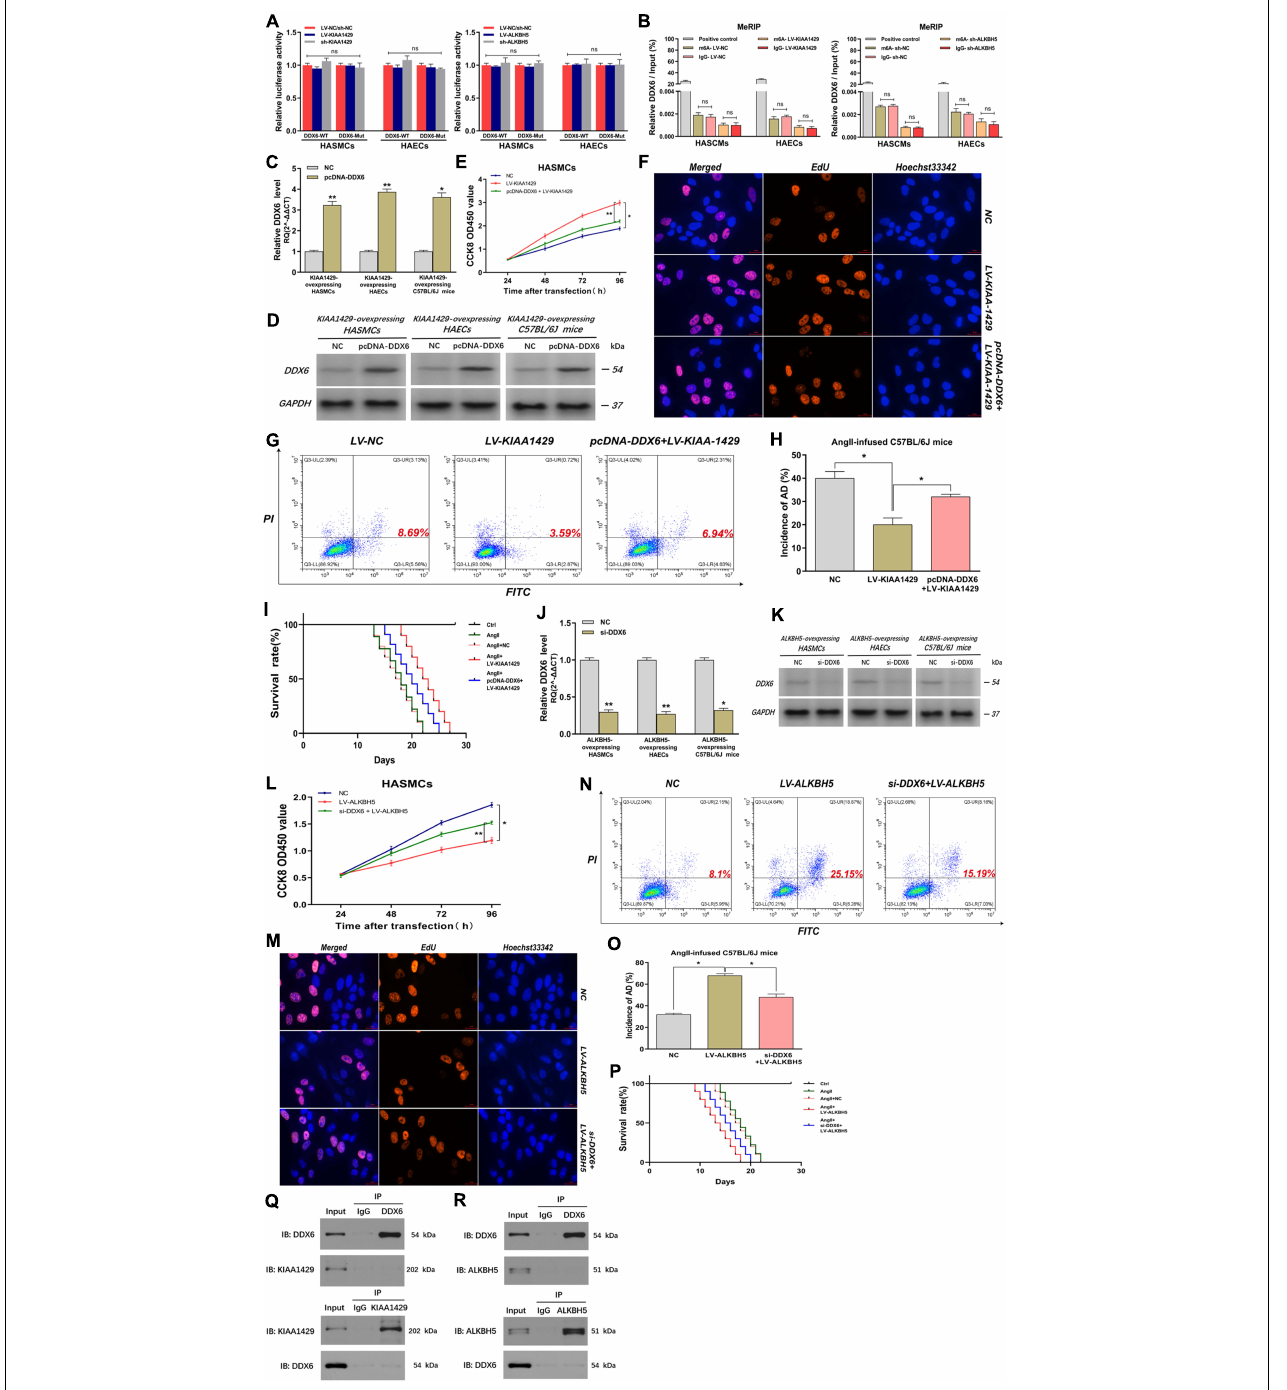
FIGURE 8 | KIAA1429 and ALKBH5 affect AD progression via the miR-143-3p/DDX6 pathway. (A,B) After the binding site of the 3 (cid:48) -UTR region of DDX6 was mutated, both the luciferase activity and the amount of DDX6 precipitated by m6A and IgG did not change significantly when KIAA1429 or ALKBH5 was disturbed. (C,D) The effect of elevating DDX6 level in KIAA1429-overexpressing HASMCs, HAECs, and AngII-infused mice was detected. (E–I) The enrichment of DDX6 could partly counteract the effect of the pro-proliferative effect on HASMCs, the anti-apoptotic effect on HAECs, and the inhibitory effect on AD progression in mice induced by KIAA1429 overexpression. (J,K) The effect of reducing DDX6 level in ALKBH5-overexpressing HASMCs, HAECs, and AngII-infused mice was examined. (L–P) The reduction of DDX6 could partly counteract the effect of the anti-proliferative effect on HASMCs, the pro-apoptotic effect on HAECs, and the promotional effect on AD progression in mice induced by KIAA1429 overexpression. (Q,R) Neither KIAA1429 nor ALKBH5 could directly bind to DDX6. Data are presented as the mean ± SEM ( N ≥ 3 per group); * p < 0.05, ** p < 0.01, and ns p > 0.05.